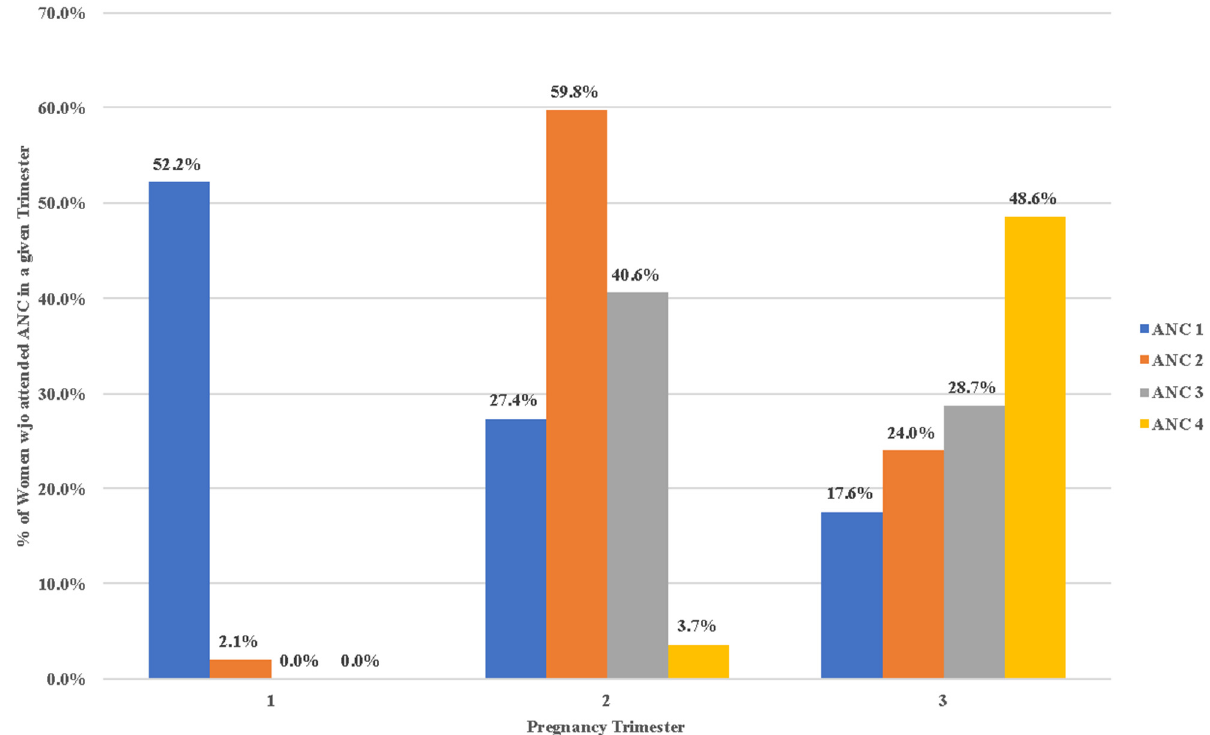
Figure 2. ANC visits per Trimester. ANC = Antenatal care.